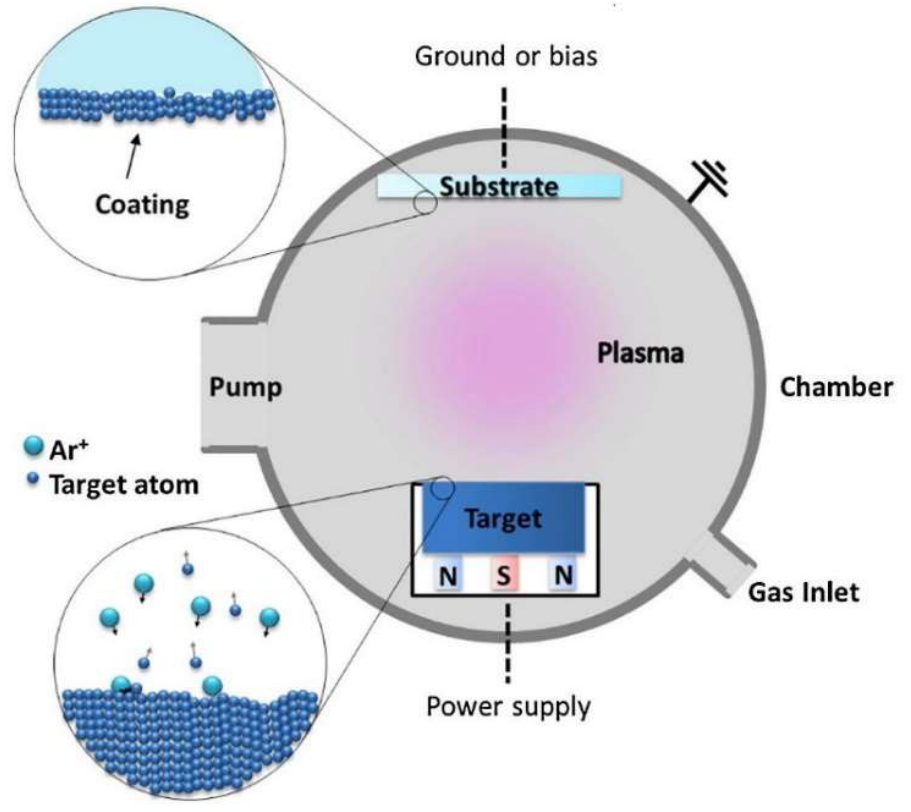
Figure 1. A schematic diagram of magnetron sputtering. Reproduced with permission from [20]. Copyright 2016, Elsevier.